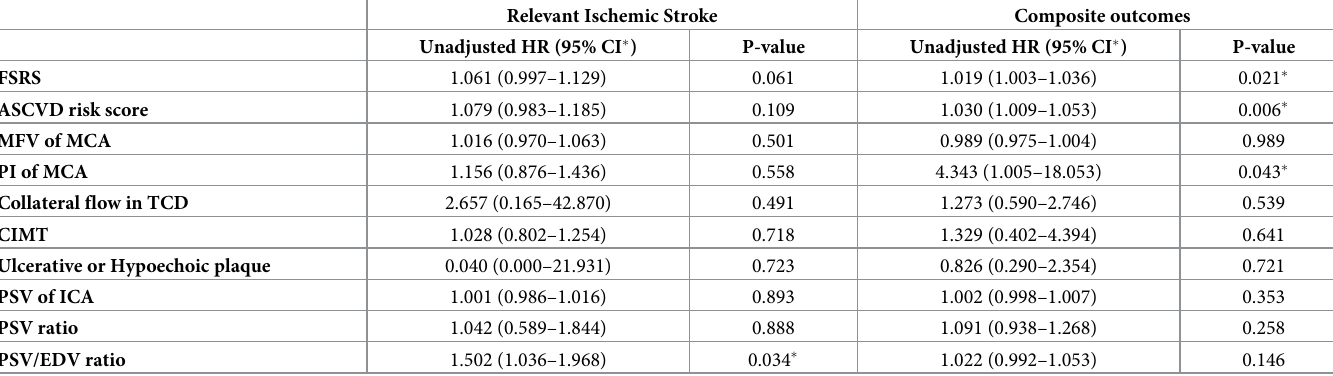
Table 2. Factors associated with the relevant ischemic stroke or composite outcomes.